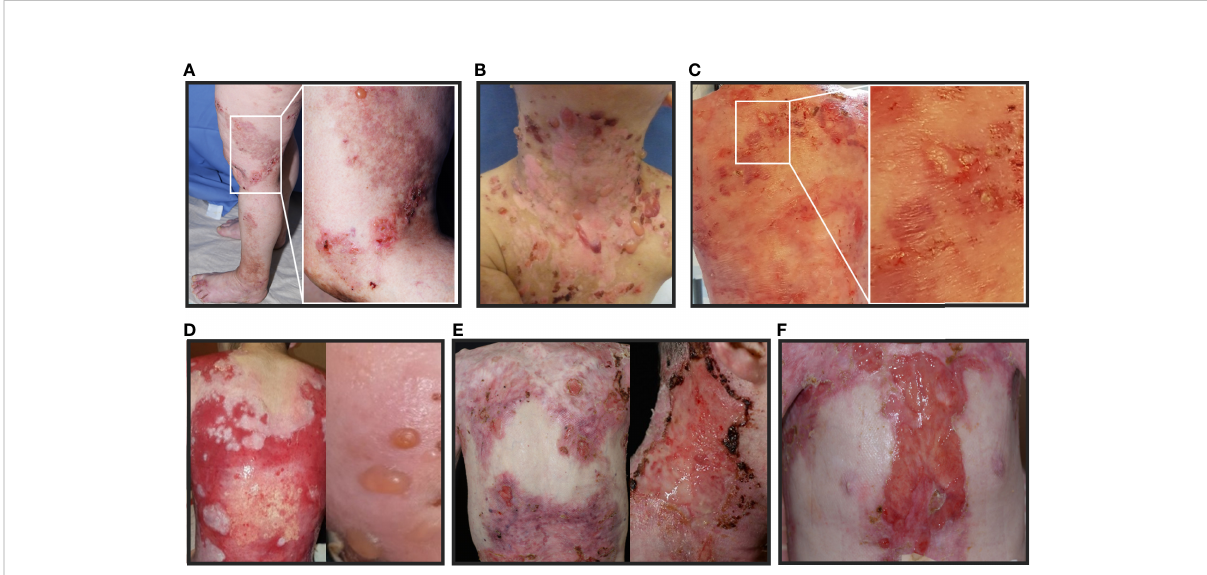
FIGURE 2 Clinical pictures of the patients with EB and AIBD described in this study: (A – F) : Patients present with tense blisters, erosions and ulcerations simultaneously, which are characteristic for both, EB and AIBD. Therefore, conclusive clinical differentiation is challenging. (A) patient 1, (B) patient 2, (C) patient 3, (D) patient 4, (E) patient 5 under therapy with programmed cell death protein 1 inhibitor (PD1i) and (F) patient 6 under therapy with